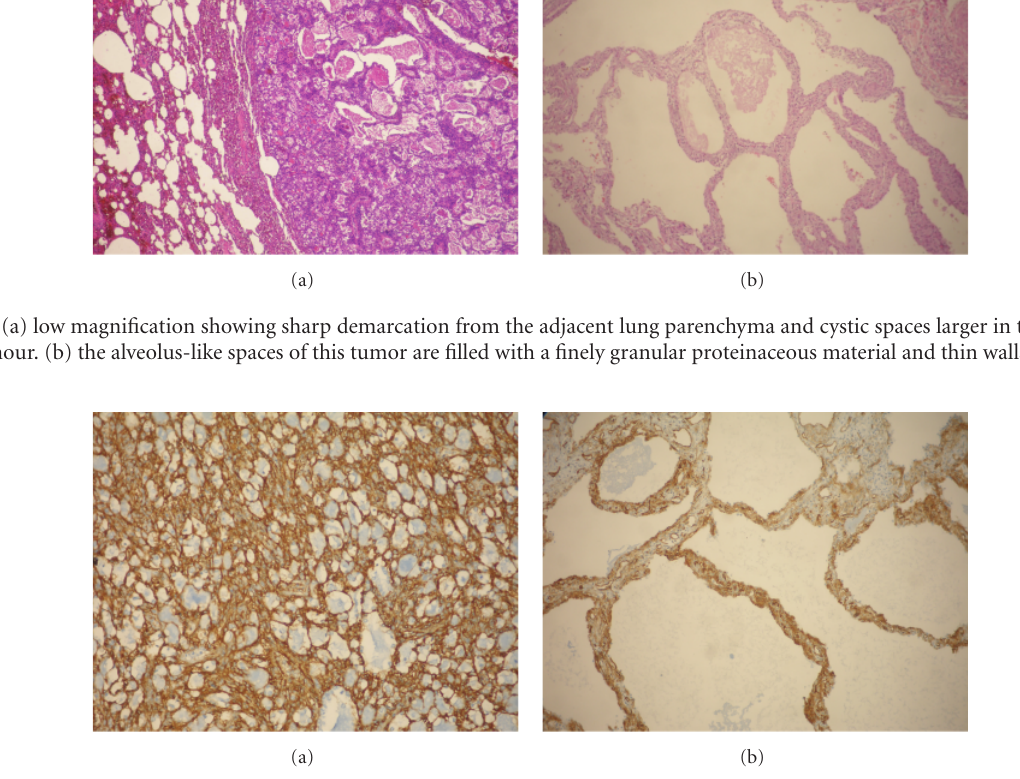
Figure 3: (a) CD34 positivity in the stromal cells (case 2). (b) CD34 positivity in the stromal cells (case